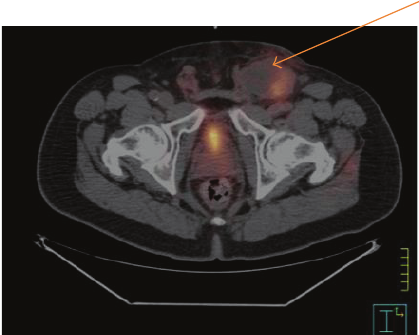
Figure 1: Initial staging PET-CT revealed SUV uptake at the base of the penis (not shown) as well as SUV uptake in a left inguinal lymph node (shown above).